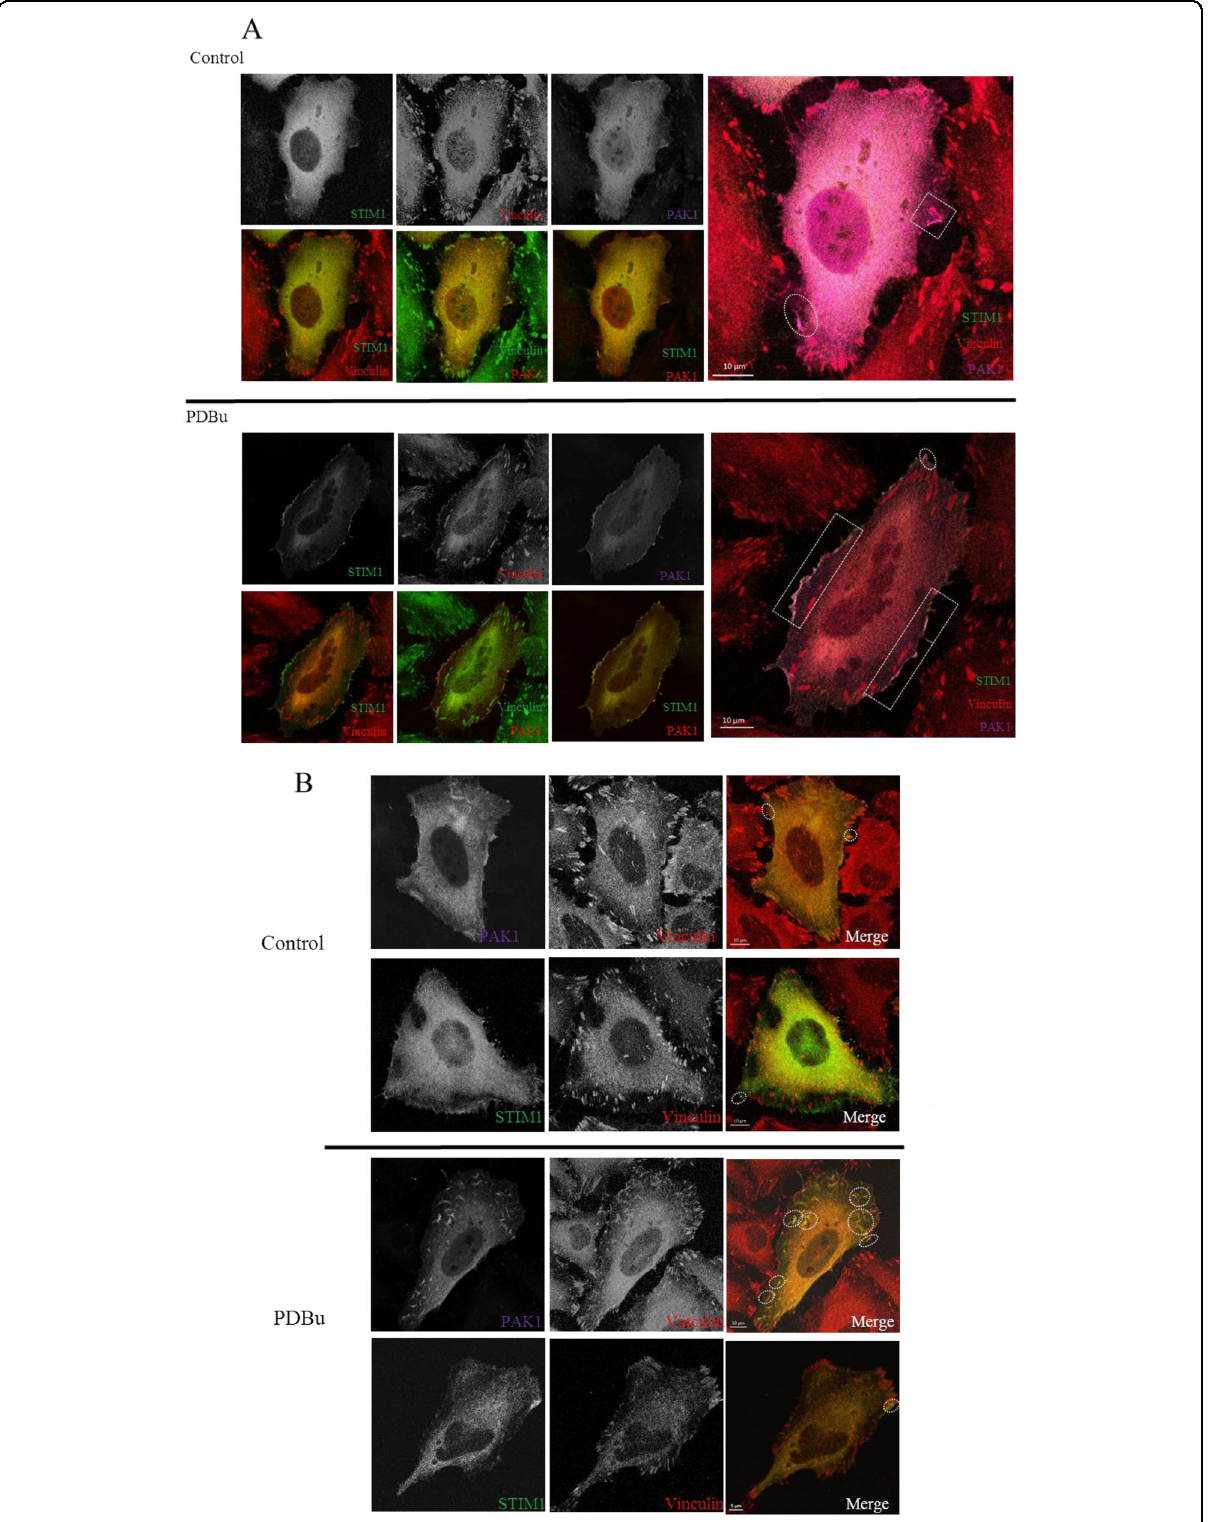
Fig. 4 PAK1 and STIM1 localize at vinculin-positive cell protrusions and nascent adhesions. PAK1 (c-myc-tagged) and/or eGFP-STIM1 plasmids were transfected into HeLa cells; after an overnight incubation, the cells were treated for 30min with ( a , b PDBu) or without 100nM PDBu ( a , b control) before processing with anti-PAK1 (c-myc) and anti-Vinculin antibodies for confocal imaging. The area where both proteins distinctly localize is marked with either boxes or